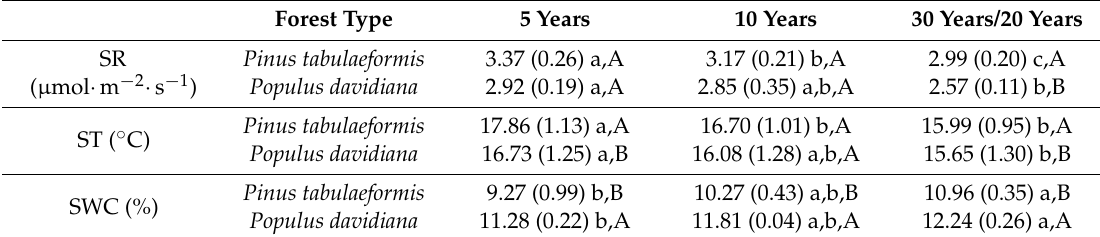
Table 2. Mean values for soil respiration (SR), soil temperature (ST), and soil water content (SWC) in Pinus tabulaeformis and Populus davidiana plantations at three different stand ages.